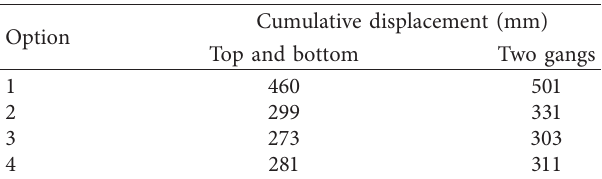
Figure 3: Plastic zone distribution of the material roadway’s surrounding rock. (a) Option 1. (b) Option 2. (c) Option 3. (d) Option 4. Table 5: The displacement curve about the material roadway’s surface in different advanced support